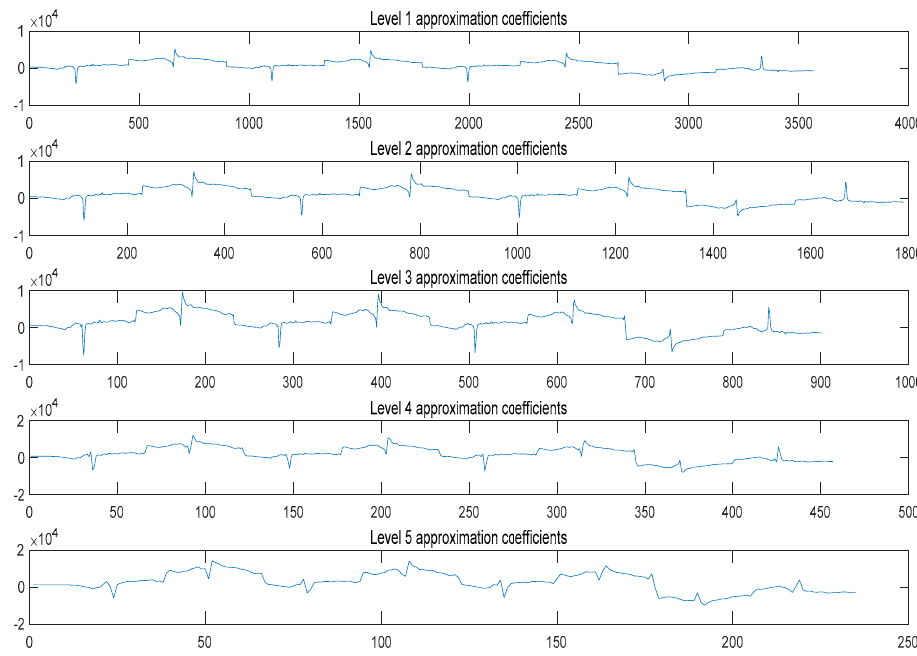
Figure 12. Approximate coefficients under different decomposition levels.